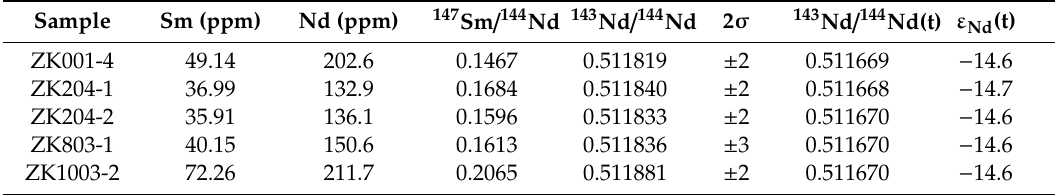
Table 4. Sm ‐ Nd isotopic result of scheelite samples from the drill core of Shangfang tungsten deposit.